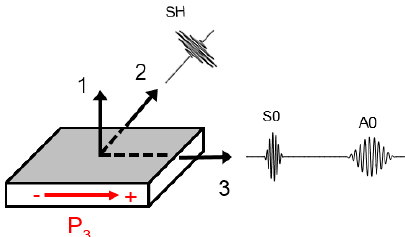
Figure 1. Schematic of a d15 piezoelectric transducer with fundamental wave modes depicted in the direction of wave propagation.